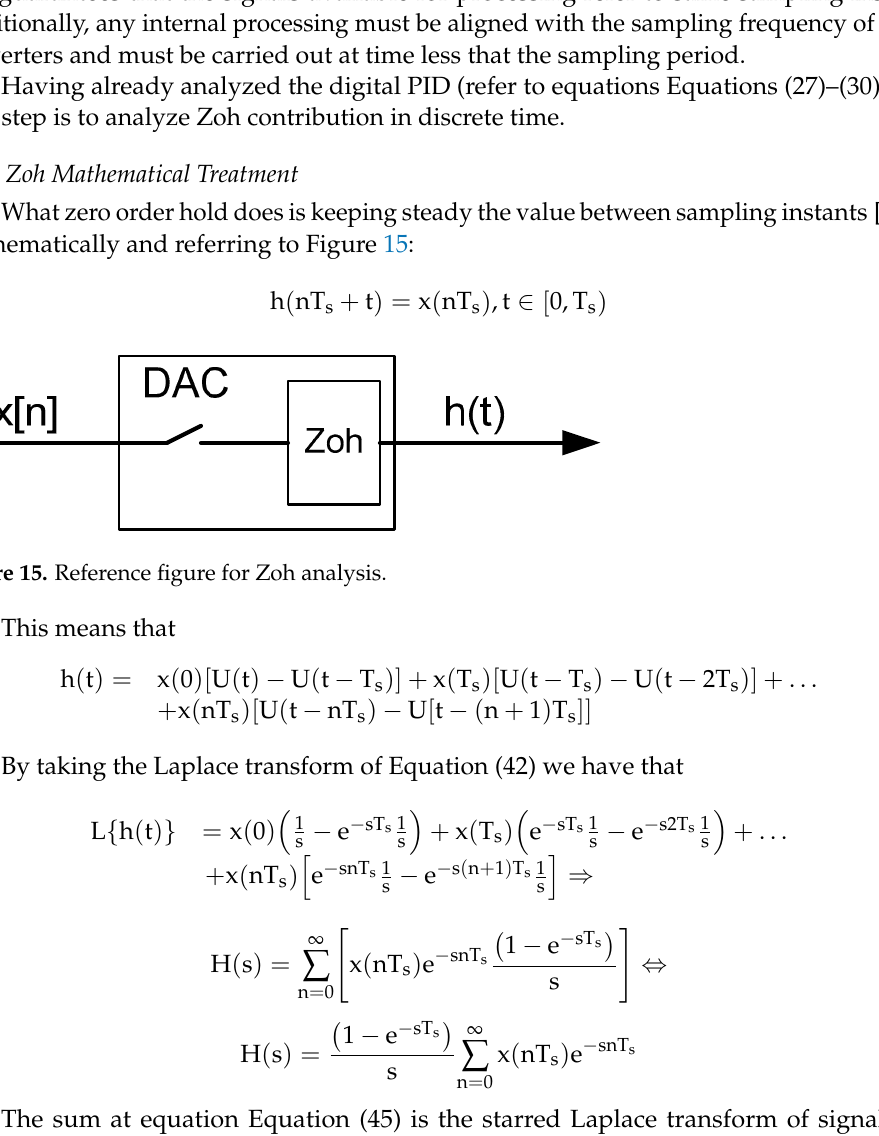
Figure 14. Control loop with PID and data converters.